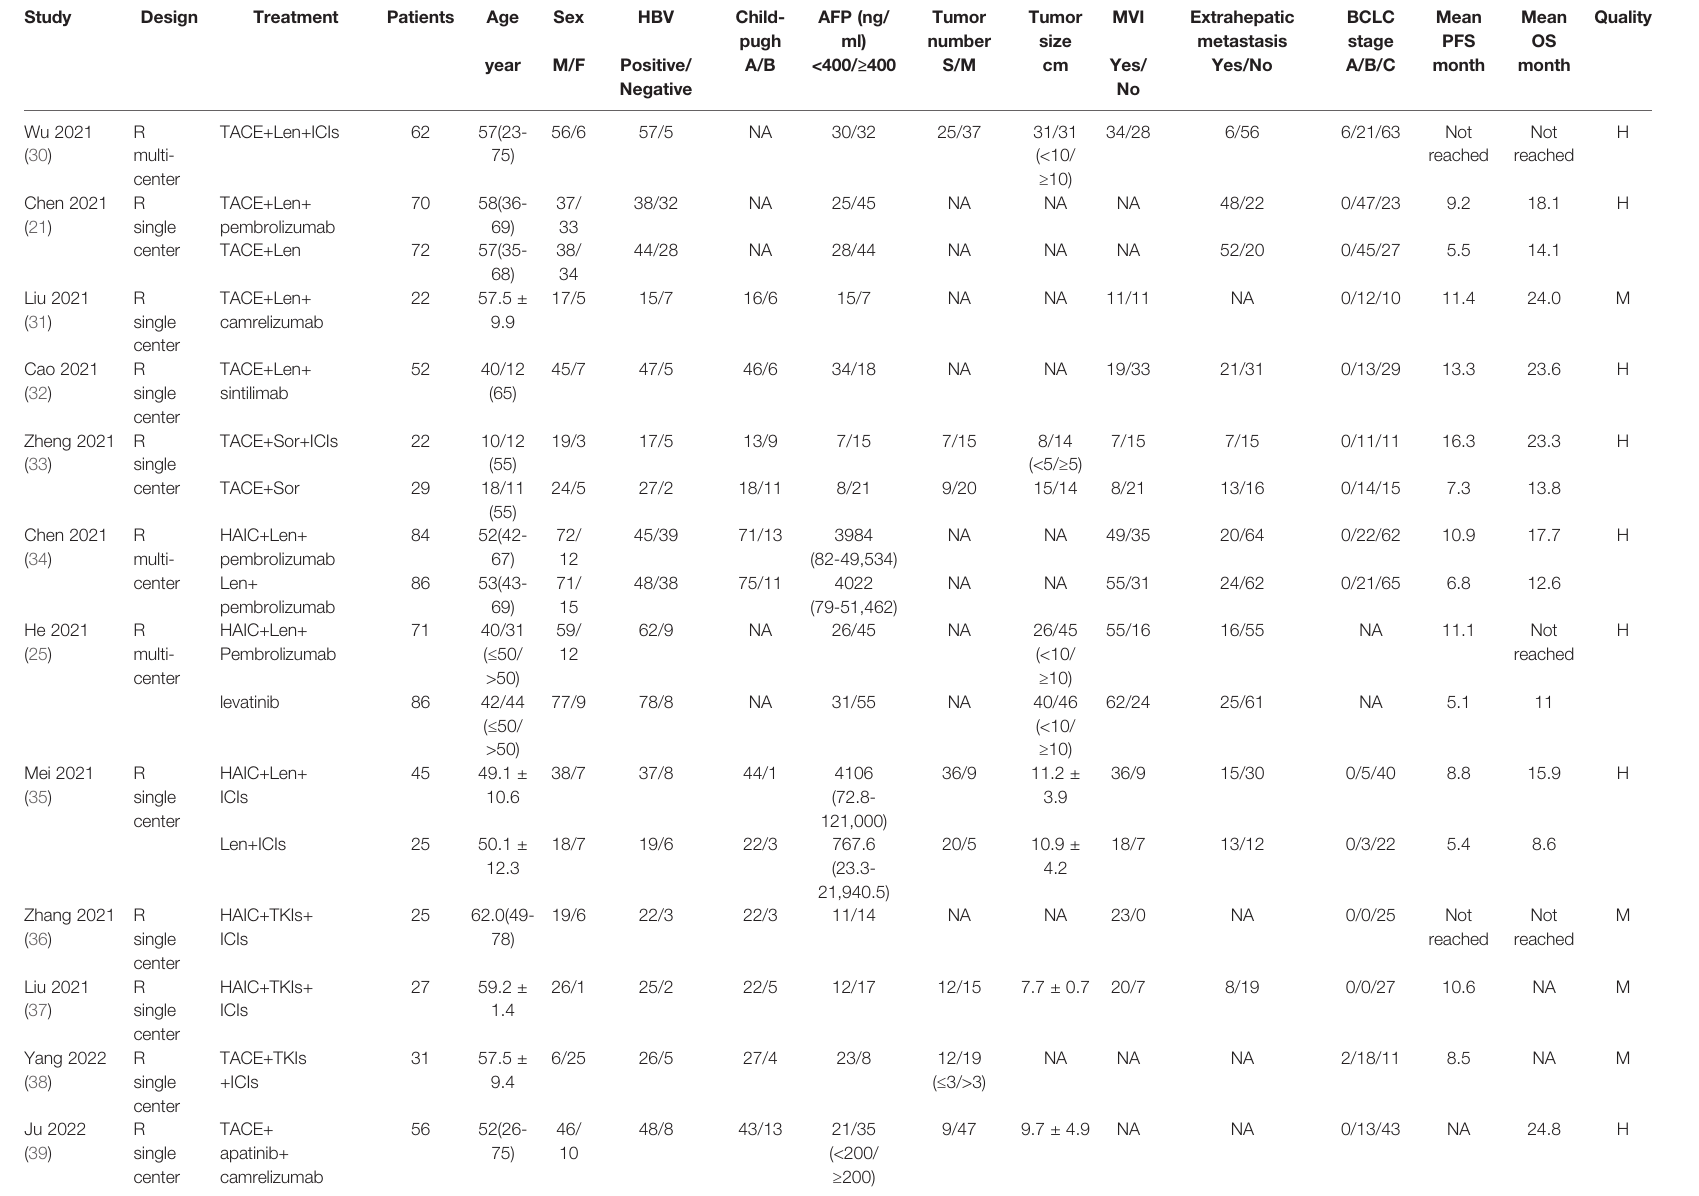
TABLE 1 | Baseline characteristics and quality assessment of included